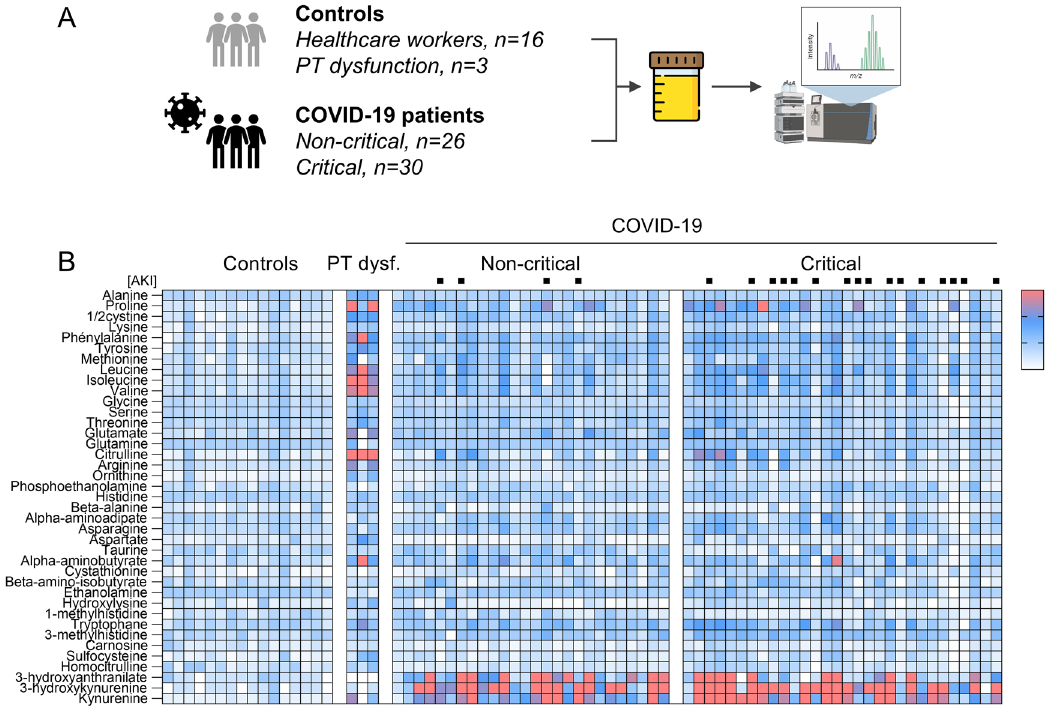
Figure 1. Urine Metabolomics in patients with COVID-19. ( A ) Study design. Urine samples obtained from patients with COVID-19 (n = 56, including 26 non-critical, 30 critical patients) were assessed using LC–MS/MS and compared to those obtained from healthy controls (n = 16 healthcare workers) and patients with proximal tubule (PT) dysfunction (n = 3) caused by tenofovir-related nephrotoxicity, Hartnup disease and Dent disease, respectively. Created in part with BioRender.com. ( B ) Heatmap of relative urinary concentrations of amino acids and metabolites in controls and patients hospitalized with COVID-19, stratified for disease severity. The 95th percentile of log-transformed values for each metabolite in healthy controls was considered as the reference. Patients with acute kidney injury (AKI) are identified by a black square on top of the